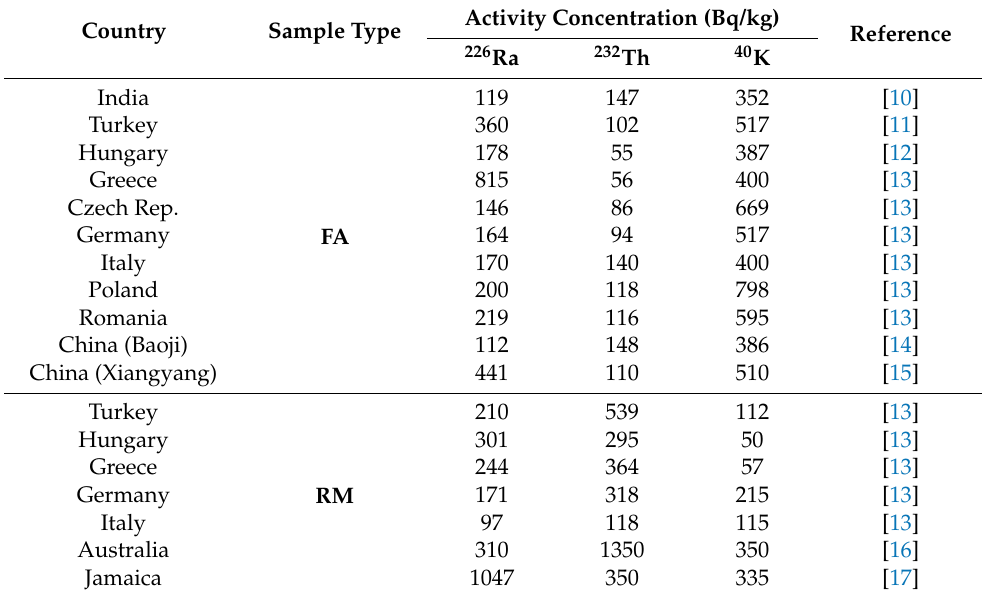
Table 1. The obtained average activity concentrations of 226 Ra, 232 Th, and 40 K in FA, RM, PG, and EMR samples from similar studies in different parts of the world (unit: